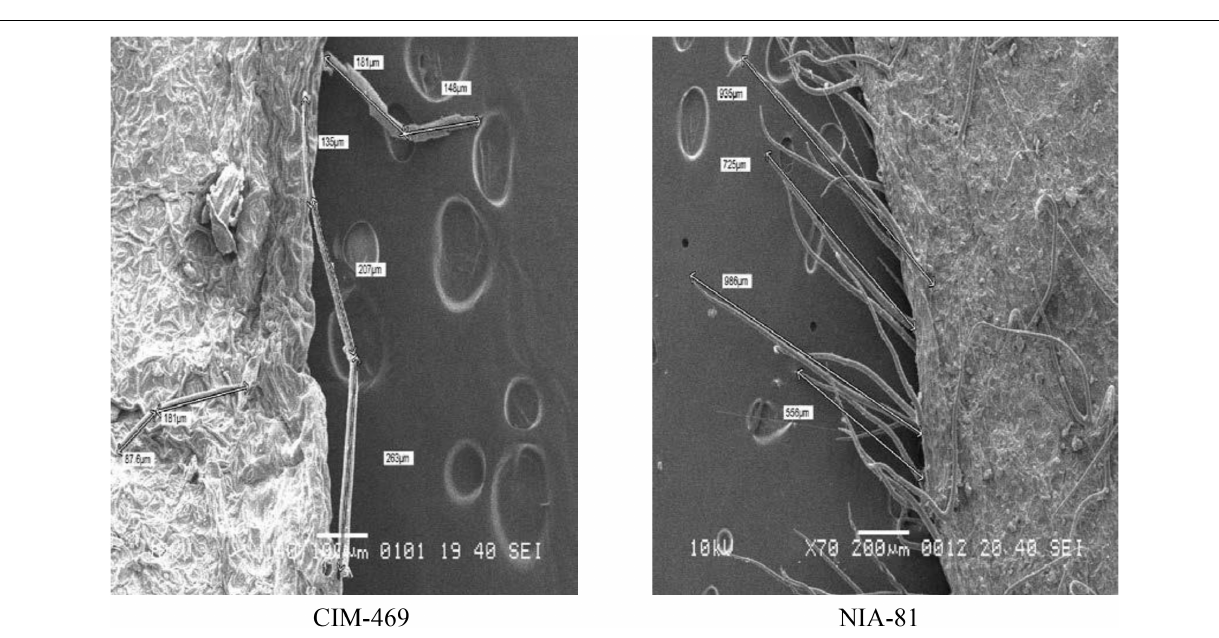
FIGURE 2 | Difference in trichome size of heat-susceptible (CIM-469) and heat-tolerant (NIA-81) cotton genotypes revealed through